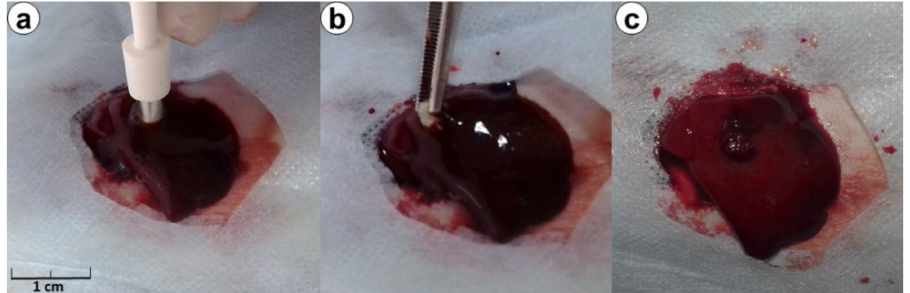
Figure 1. Procedure of punch biopsy liver trauma ( a ), hemostatic application ( b ) and liver after hemostasis procedure ( c